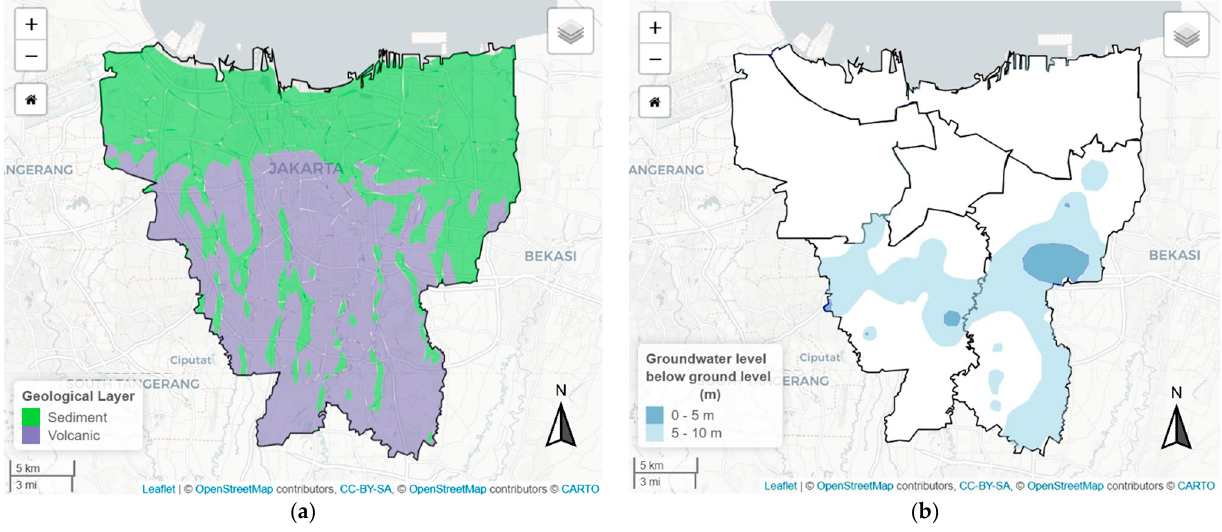
Figure 5. ( a ) Geological layers in Jakarta’s groundwater basin. ( b ) Areas of controlled groundwater abstraction. ter